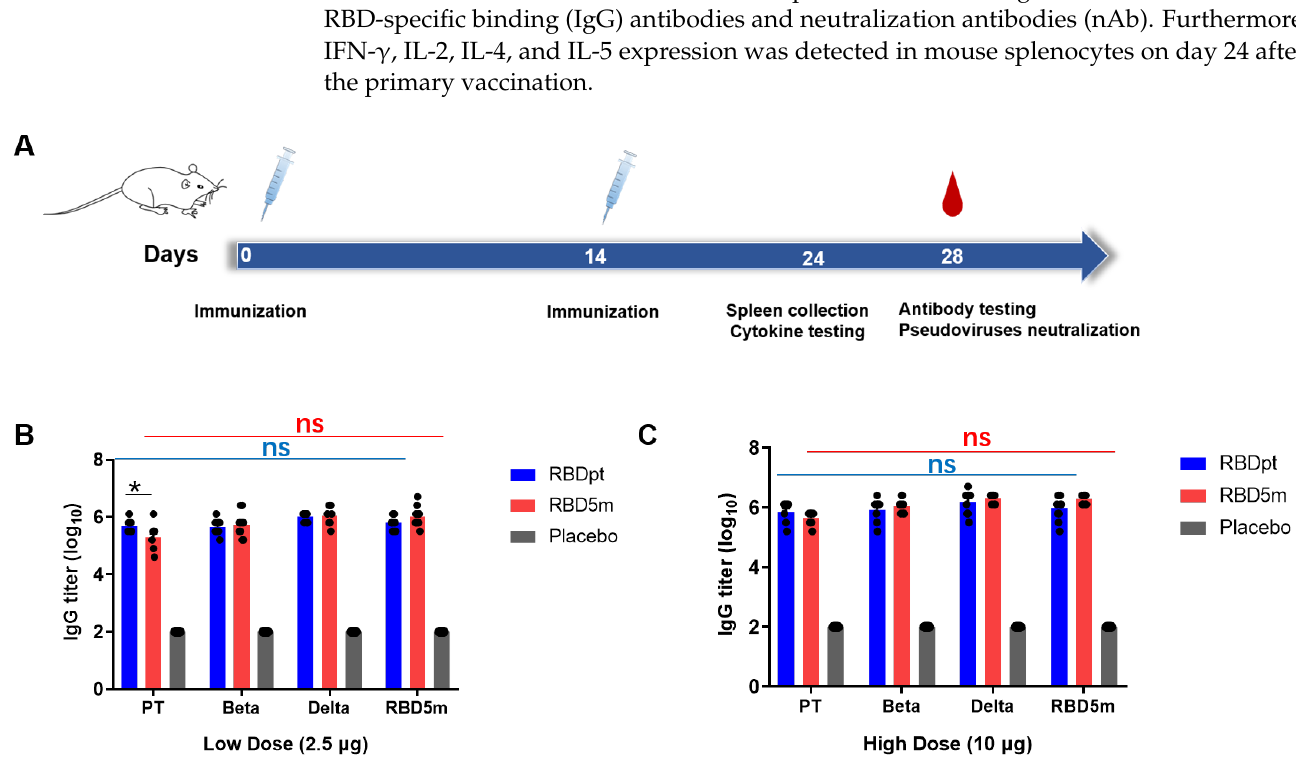
Figure 3. SARS-CoV-2 RBD-specific binding antibody titers. ( A ) Schematic diagram of immunization and serum sample collection. BALB/c mice were immunized at days 0 and 14 via an intramuscular injection at a volume of 100 µ L. Blood samples were collected at day 28 after the primary vaccination for use in an RBD-specific binding antibody titer test and a neutralization activity analysis. ( B , C ) RBD-specific IgG antibody titers of the low-dose (2.5 µg) groups ( B ) or high-dose (10 µg) groups ( C ) of RBDpt and RBD5m against the RBDs of the prototype strain (PT), Beta, and Delta SARS-CoV-2 and against RBD5m, as determined by using ELISA. ns: no significant difference; * p < 0.05.